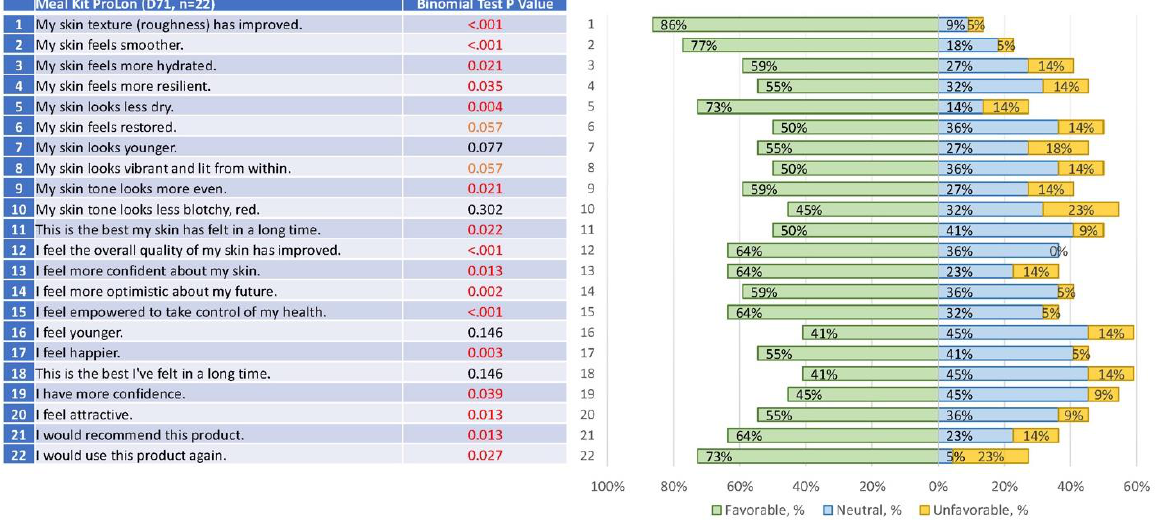
Figure 4. Self-reported Skin Assessments. The p -values for the comparisons on self-reported outcomes are shown ( left ) in relation to the responses ( right ).